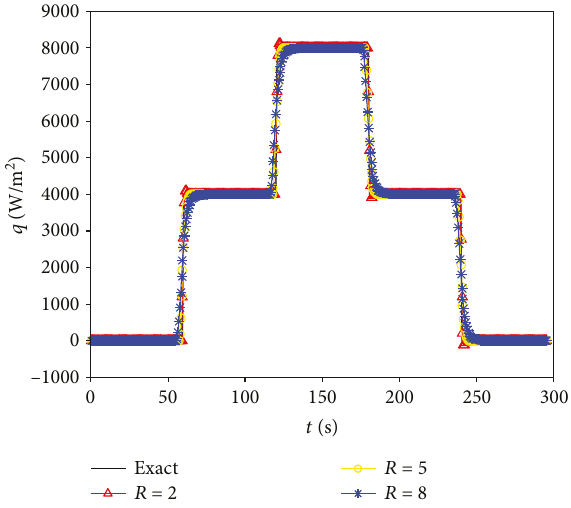
Figure 5: Impacts of di ff erent future time steps on inversion results when σ = 0 00 and L = 0 01m .